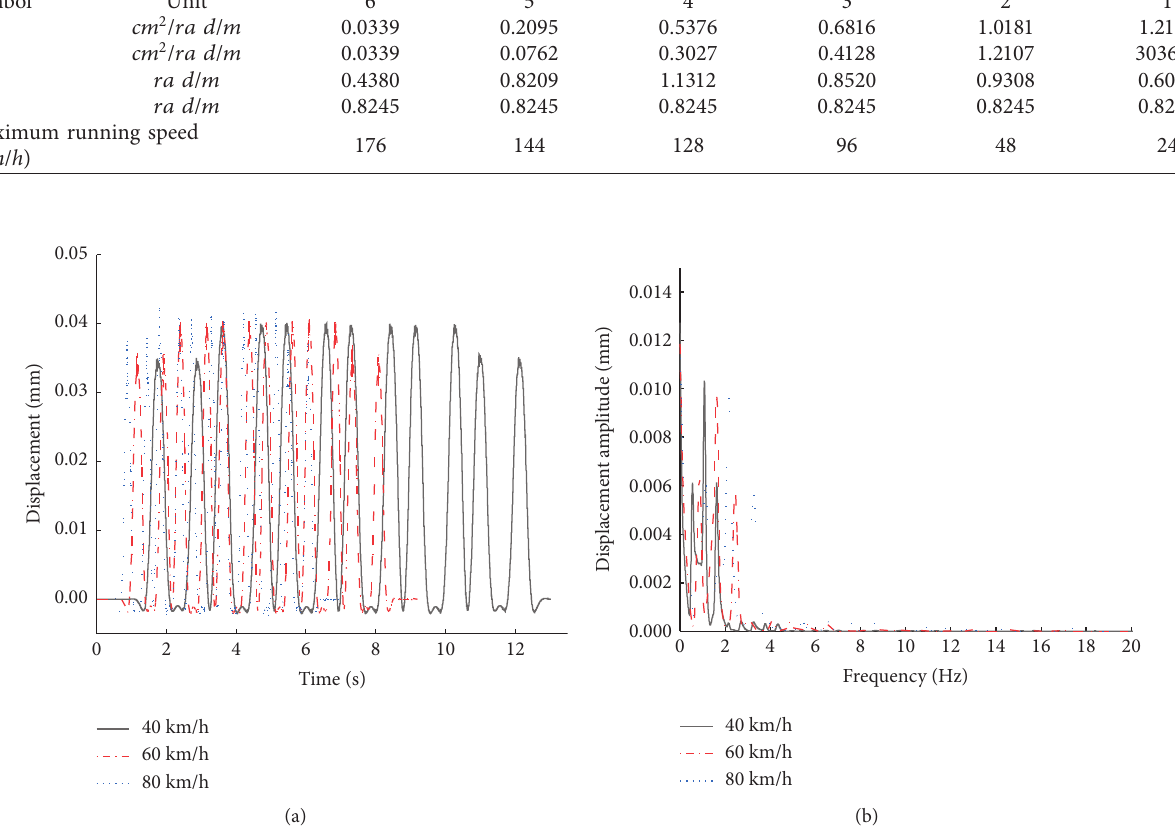
Figure 5: Vertical displacement (a) time-history curve and (b) amplitude-frequency cure of left monitoring point of trackbed at different velocities.